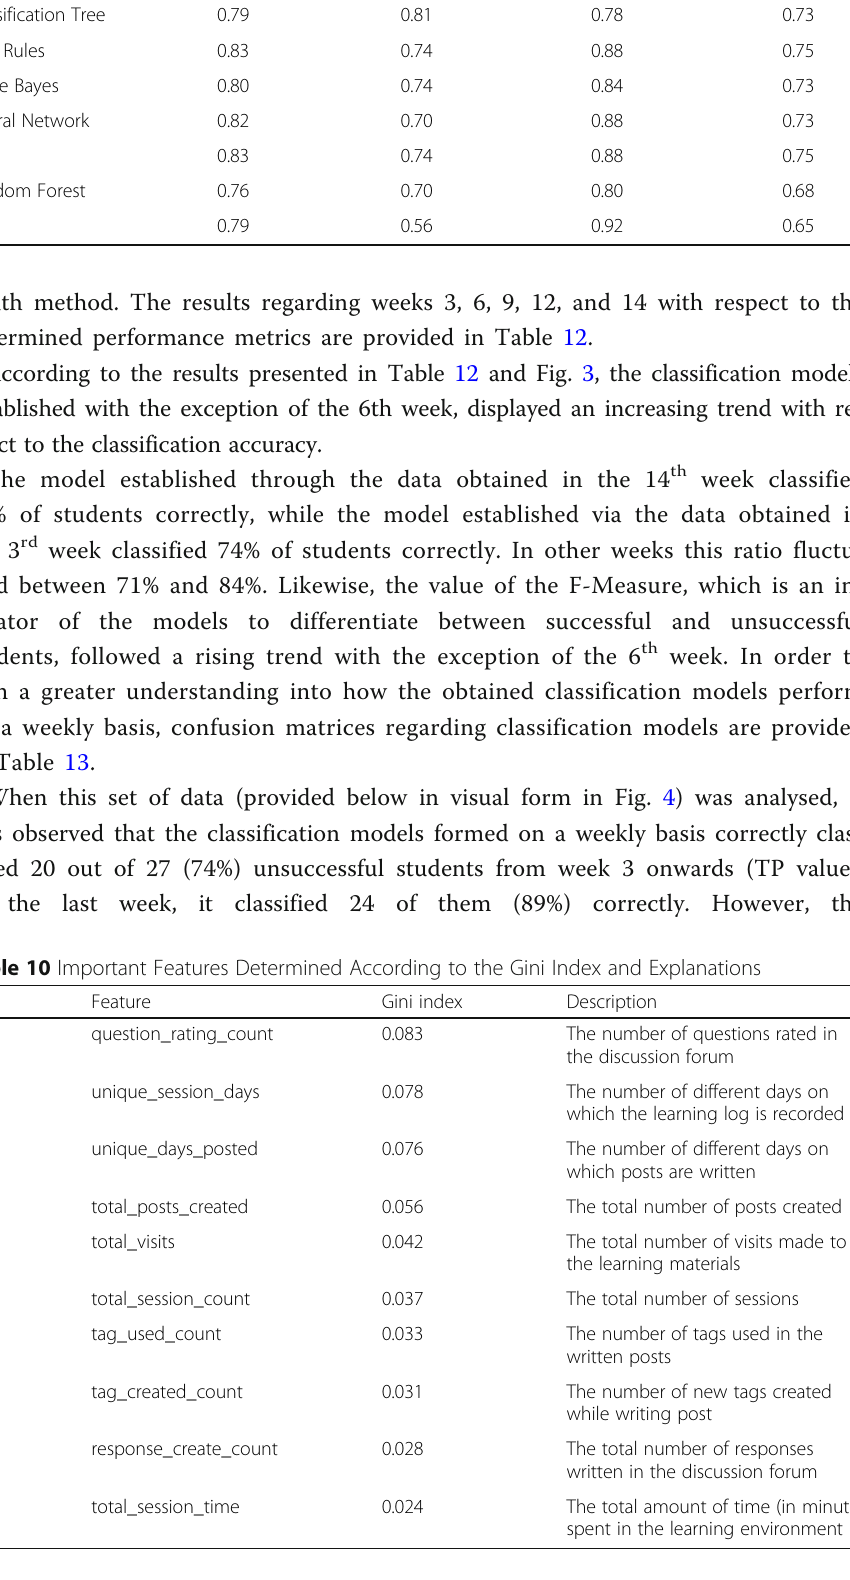
Table 9 Data Transformation: Equal Width, Feature Selection: SVM Weights Algorithm Accuracy